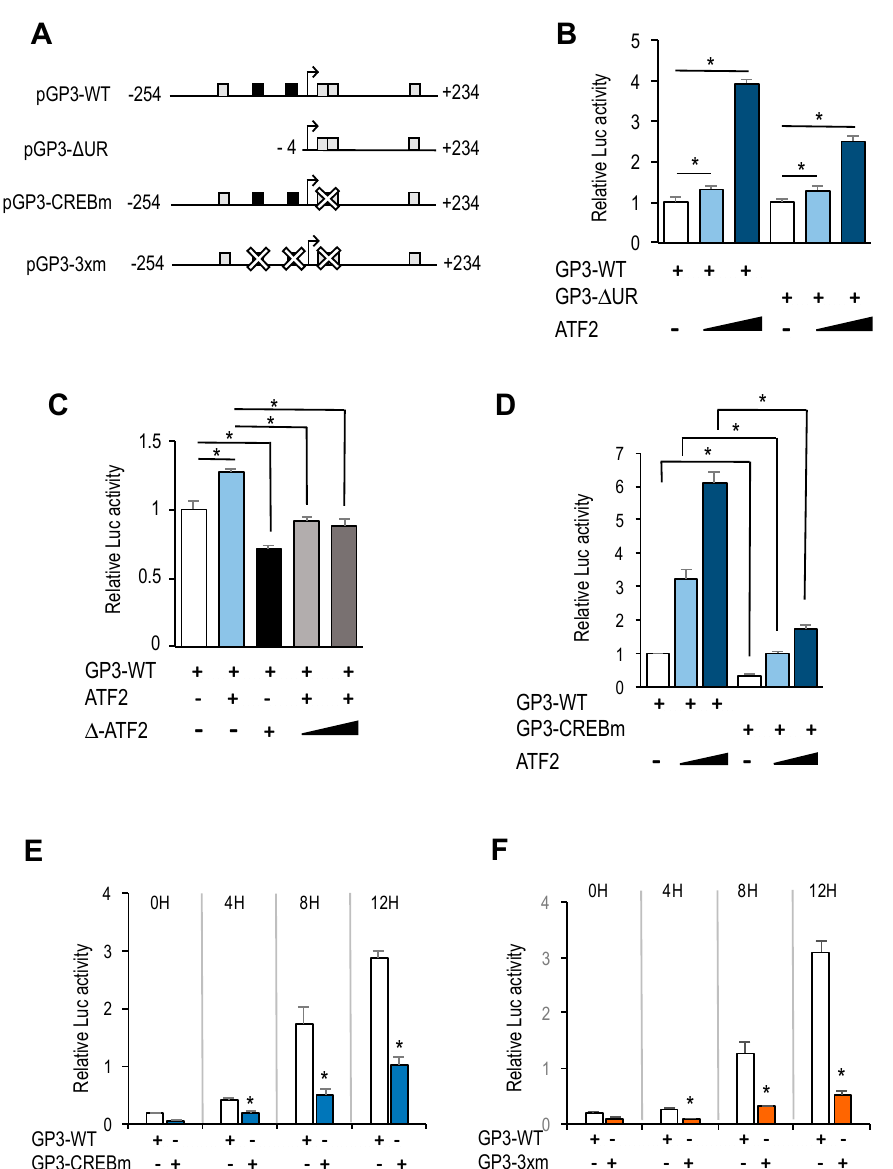
Figure 5. CREB/ATF binding motifs are critical regulators of GOLPH3 promoter activity. ( A ) Promoter-luciferase constructs of GOLPH3 and its derivatives. Mutant motifs are depicted with a white cross. ( B ) Asynchronous U2OS cells were transfected with the indicated luciferase reporter constructs along with pRL-TK and various amounts of a plasmid expressing ATF-2 (150 ng, 300 ng). Values are represented as luciferase activities relative to pGP3-WT or pGP3- ∆ UR activity of cells transfected with empty pCMV control. ( C ) U2OS cells were transfected with pGP3-WT along with a plasmid expressing ATF2 (300 ng), a plasmid expressing ∆ -ATF2 (300 ng) or both. Values are represented as luciferase activities relative to pGP3-WT activity of cells transfected with empty pCMV control. ( D ) Asynchronous U2OS cells were transfected with the indicated reporter constructs and various amounts of a plasmid expressing ATF-2 (150 ng, 300 ng). Values are represented as luciferase activities relative to pGP3-WT activity of cells transfected with empty pCMV control. ( E,F ) U2OS cells were transfected with the indicated reporter constructs along with pRL-TK and synchronized in mitosis. Subsequently, cells were released into the cell cycle and luciferase values were calculated as relative values of firefly luciferase activities relative to Renilla activities in each sample. Shown are the results of a representative experiment of two independent experiments. *, p < 0.05.